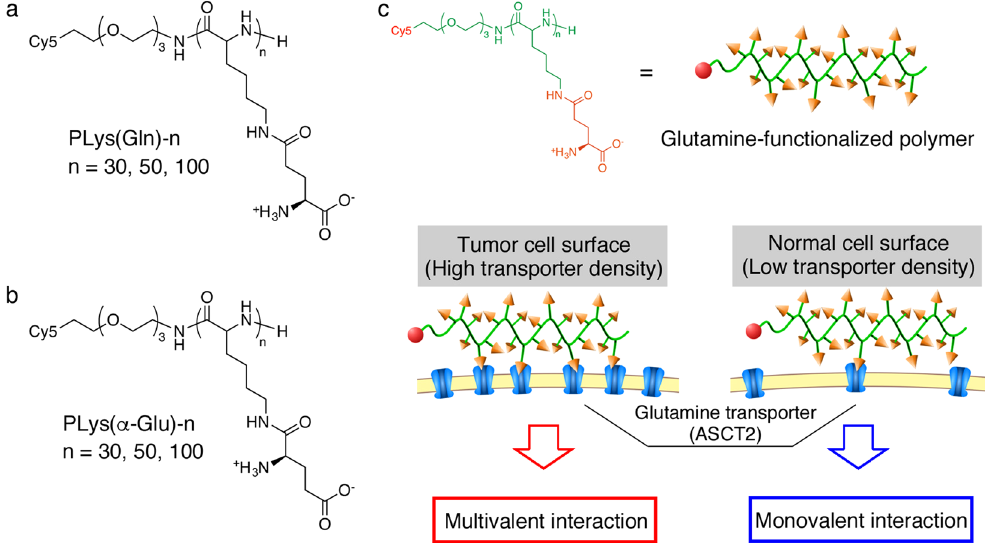
Figure 1. Design of glutamine-functionalized polymer and interaction of the polymer with cell surface. ( a , b ) Chemical structure of PLys(Gln)-n ( a ) and PLys( α -Glu)-n ( b ). ( c ) Illustration of interaction between the glutamine-functionalized polymer and cell surface. The polymer strongly interacts with tumour cell surface by multivalent interaction associated with high transporter density. In contrast, the polymer weakly interacts with normal cell surface because of low transporter